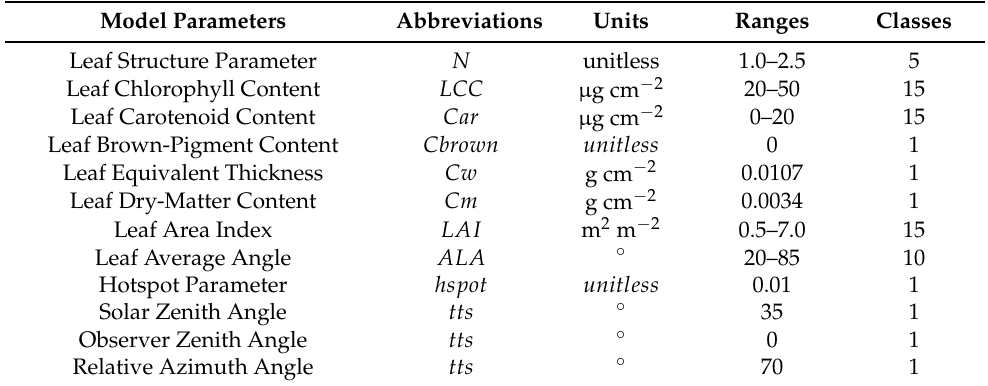
Table 1. Parameters used in PROSAIL model for paddy rice canopy reflectance simulation. N , LCC , Car , LAI , and ALA were generated by uniform